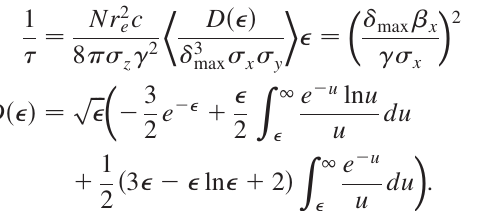
FIG. 10. Plot of Touschek lifetime vs shows a clear linear relation. The figure was taken from [14].